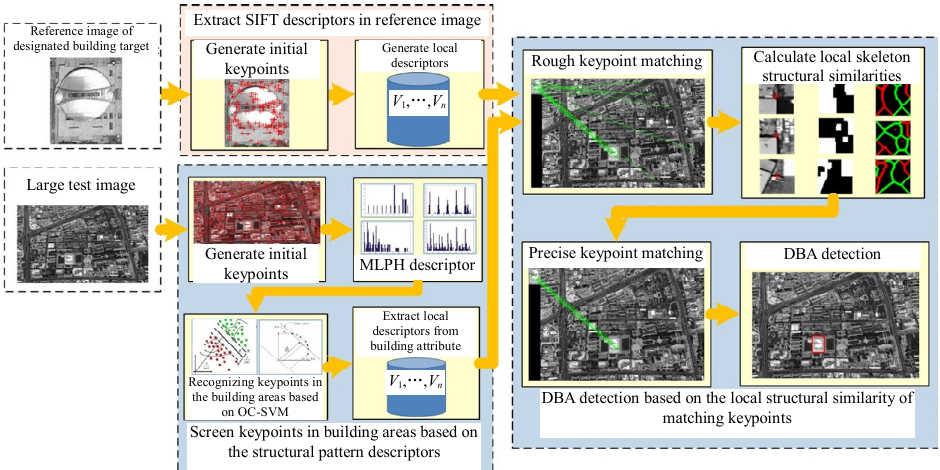
Fig. 1 Workflow of the proposed detection algorithm.